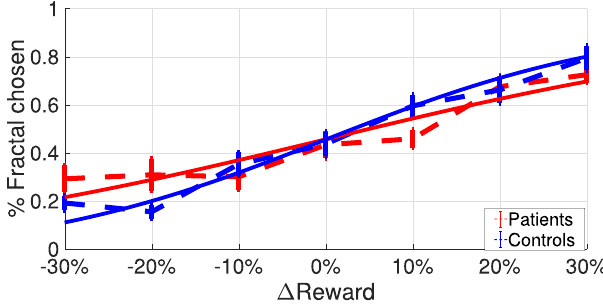
Figure 2. Average sigmoid functions (solid lines) fitted to psychometric curves (dashed lines) of the two groups of the fMRI dataset. Dashed lines depict the average proportion of responses in which the fractal was chosen as a function of the difference between estimated and explicit reward probabilities. Solid lines show the average of simple sigmoid functions fitted to the psychometric curves of individuals. A perfect observer would never choose the fractal when the explicit probability is higher ( − 30%, − 20%, − 10%) and always choose the fractal when the estimated probability is higher (10%, 20%, 30%). An unbiased observer would be expected to choose the fractal in half of the trials when reward probability is the same for both options. Error bars represent between subjects standard errors.